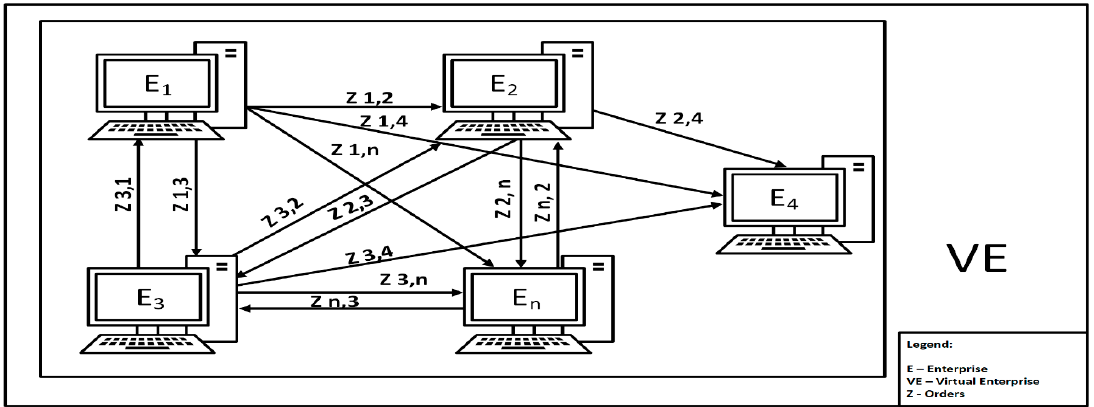
Figure 1. Open tender for the execution of a production order using consortium blockchain.